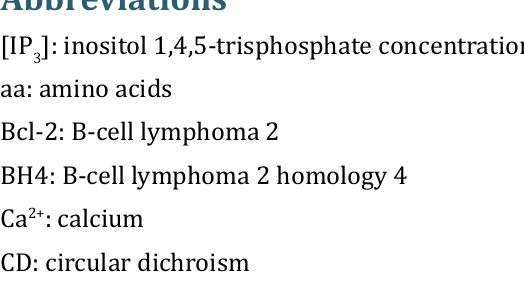
IP R o 3 R, however with lower 3